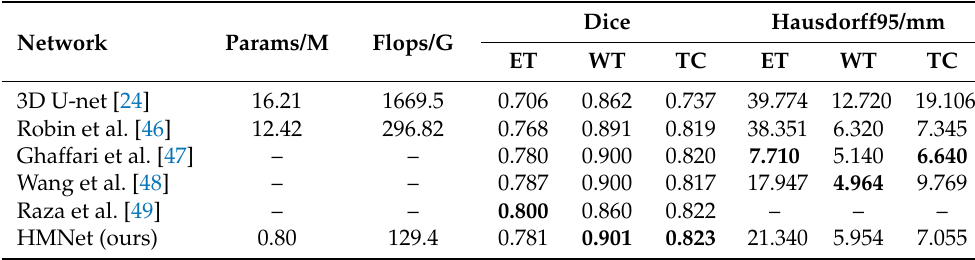
Table 4. Comparison with other non-lightweight brain tumor segmentation networks on the BraTS 2020 validation set. A (–) denotes that the results are not reported.